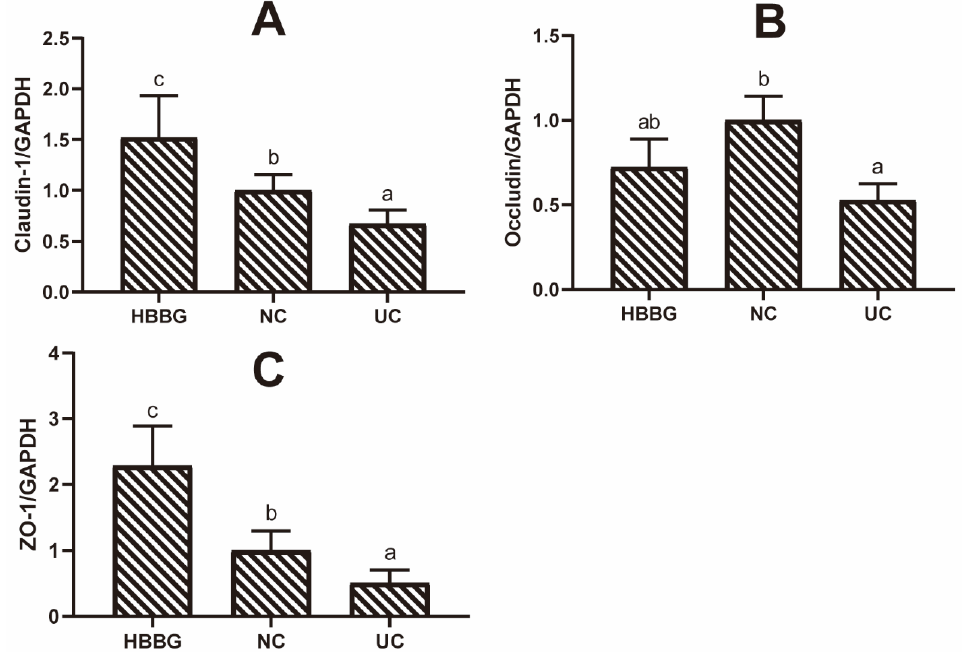
Figure 3. The effect of HBBG on mRNA expression levels of tight junction-related proteins: ( A ) claudin-1; ( B ) occludin; ( C ) ZO-1. Different letters indicate statistically significant differences ( p < 0.05); on the contrary, the same letters indicate no statistically significant differences ( p > 0.05).